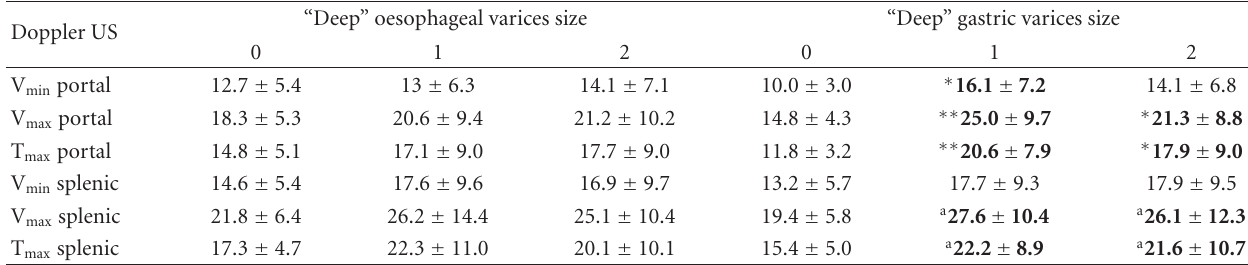
Table 2: Summary of Doppler ultrasound findings in relation to the size of “deep” oesophageal and gastric varices in the liver cirrhosis patients ( n = 42). Data presented as mean ± SD. a P = 0 . 05; ∗ P < 0 . 05; ∗∗ P < 0 . 01 versus grade 0 varices. “Deep” oesophageal varices size “Deep” gastric varices size Doppler US